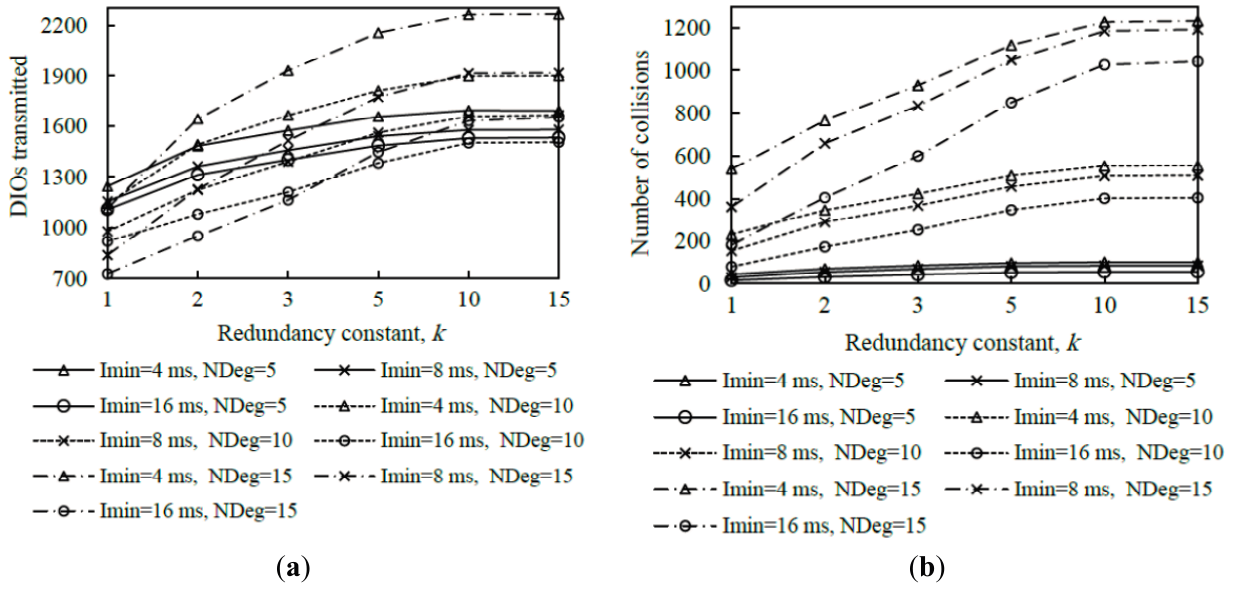
Figure 13. Average number of DIO messages transmitted and collisions in the large network scenario for different average node degrees, as a function of the redundancy constant, k , for different values of I min